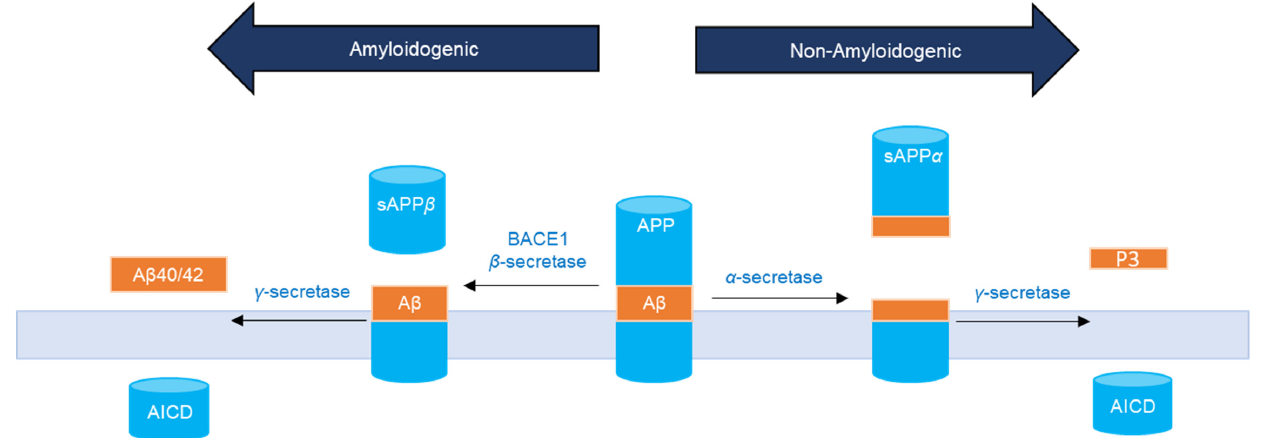
Figure 1. APP processing by two pathways. In the non-amyloidogenic pathway, α -secretase cleaves in the middle of the A β region (orange) to release sAPP α . In the amyloidogenic pathway, cleavage of APP by β - and γ -secretase yields A β 40/42 peptides.